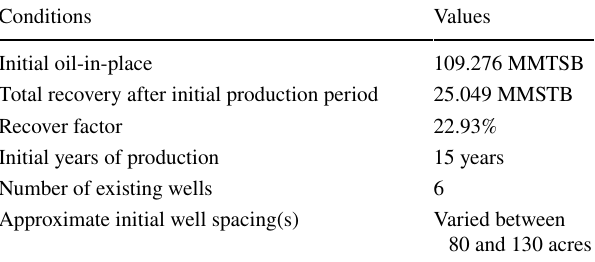
Table 4 Initial conditions of the reservoir